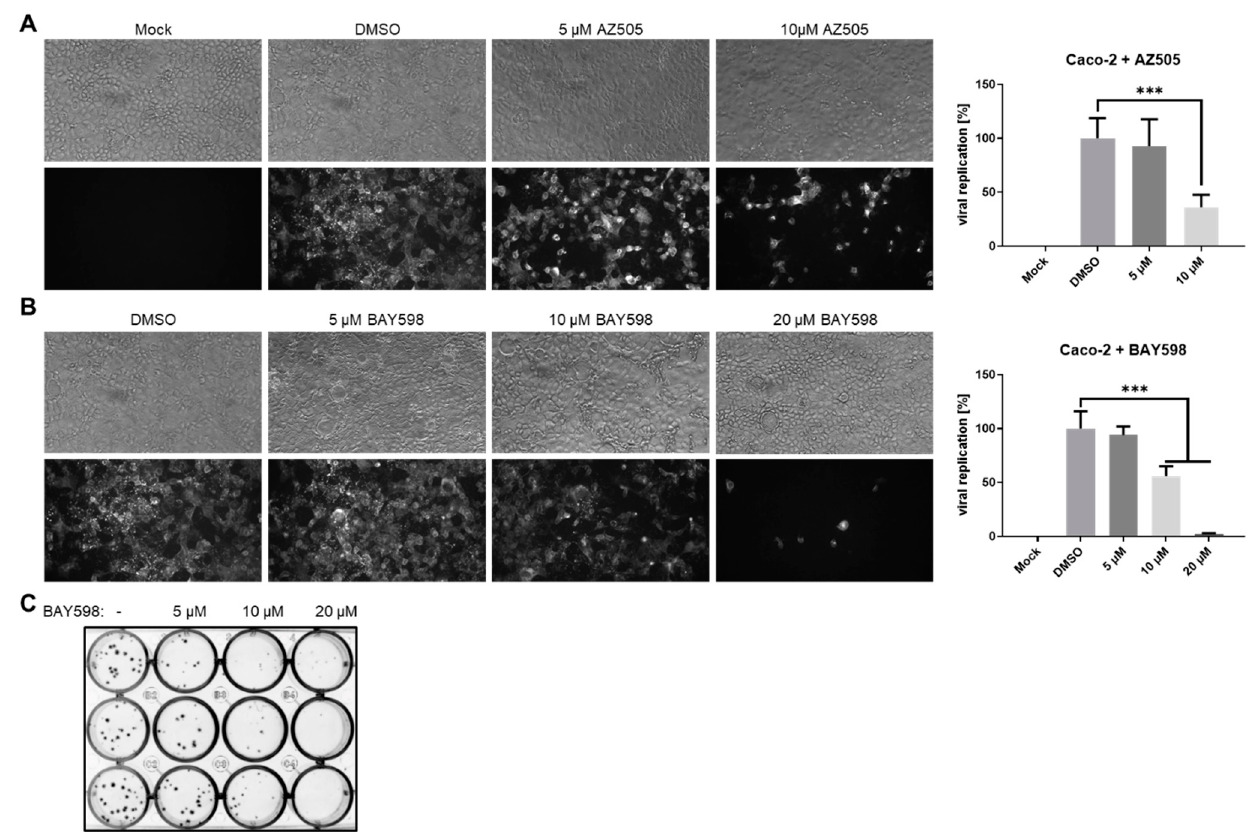
Figure 4. SMYD2 inhibition decreases SARS-CoV-2 infection in Caco-2 cells. ( A , B ) Antiviral effect of AZ505 ( A ) and BAY598 ( B ) in Caco-2 cells. Cells were treated with the indicated concentrations for 24 h prior to infection. The same amount of inhibitor was also applied during infection (MOI = 0.005). SARS-CoV-2 positive cells were visualized two days post-infection using a mAb against Spike and an Alexa488-conjugated secondary antibody under a Nikon Inverted Ts2-FL Eclipse microscope equipped with a 10x objective. The Alexa488 signal was quantified in a Victor X4 multilabel reader. Bar graphs represent mean values of eight infected wells ± SD. *** p < 0.001. N.S., not significant. One representative experiment out of three replicates is depicted. ( C ) Plaque assay of Caco-2 cells infected with a recombinant SARS-CoV-2 reporter virus expressing EYFP instead of the viral ORF6 gene (1:10,000 dilution) after treatment with the indicated concentrations of BAY598. EYFP-positive plaques were detected with a fluorescence imager two days post-infection. The experiment was repeated three times and representative results are shown.